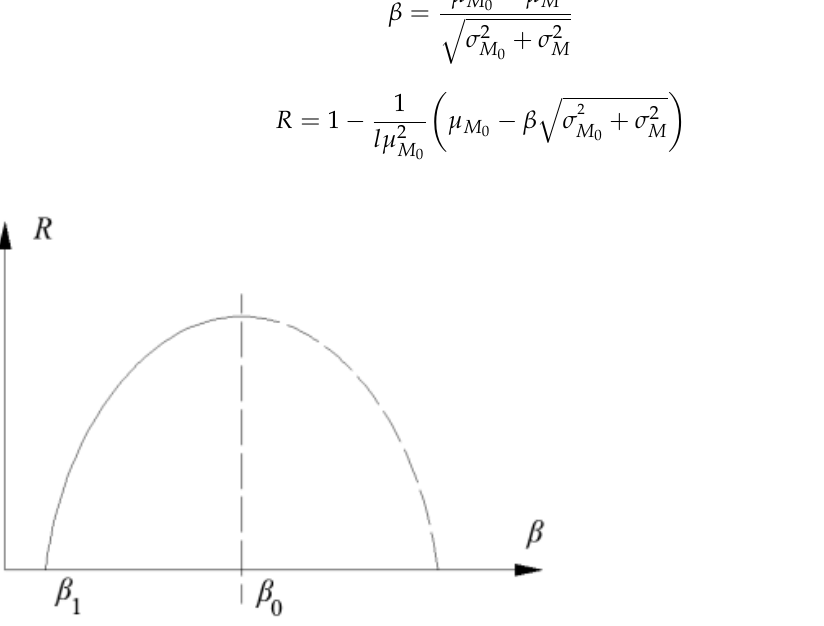
Figure 1. Mathematical relation model of structural robustness evaluation index ( R ) and structural reliability index ( β ∈ [ β 1 , β 0 ] ).